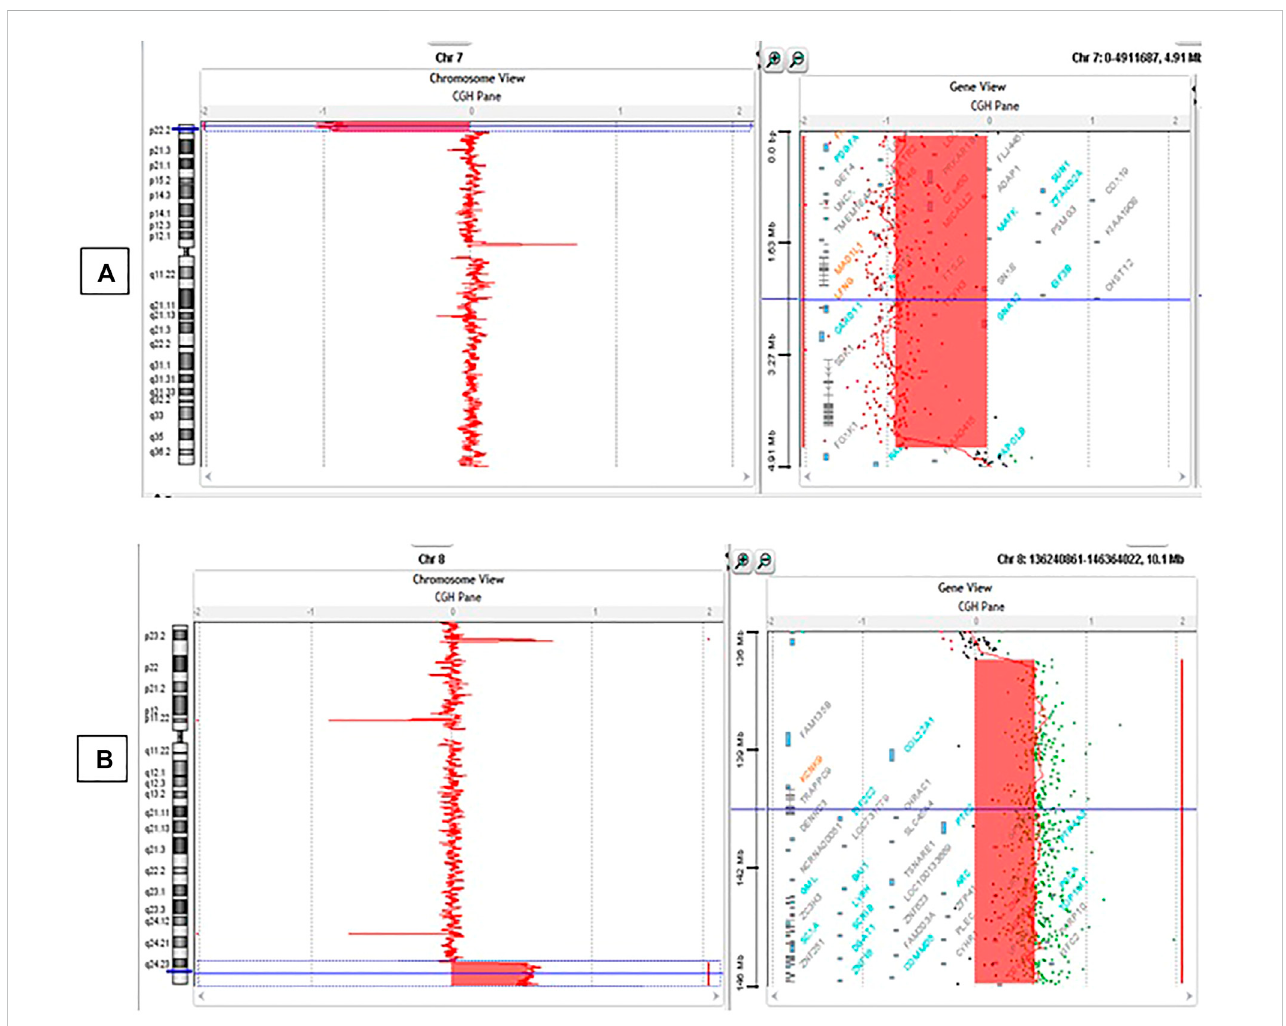
FIGURE 3 Array CGH results. (A) Deletion of 4.56 Mb in 7p22.3-p22.1 ranging from 83325bp to 4642192bp (hg19); (B) Duplication of 9.20 Mb in 8q24.23- q24.3 ranging from 137078730bp to 146280020bp